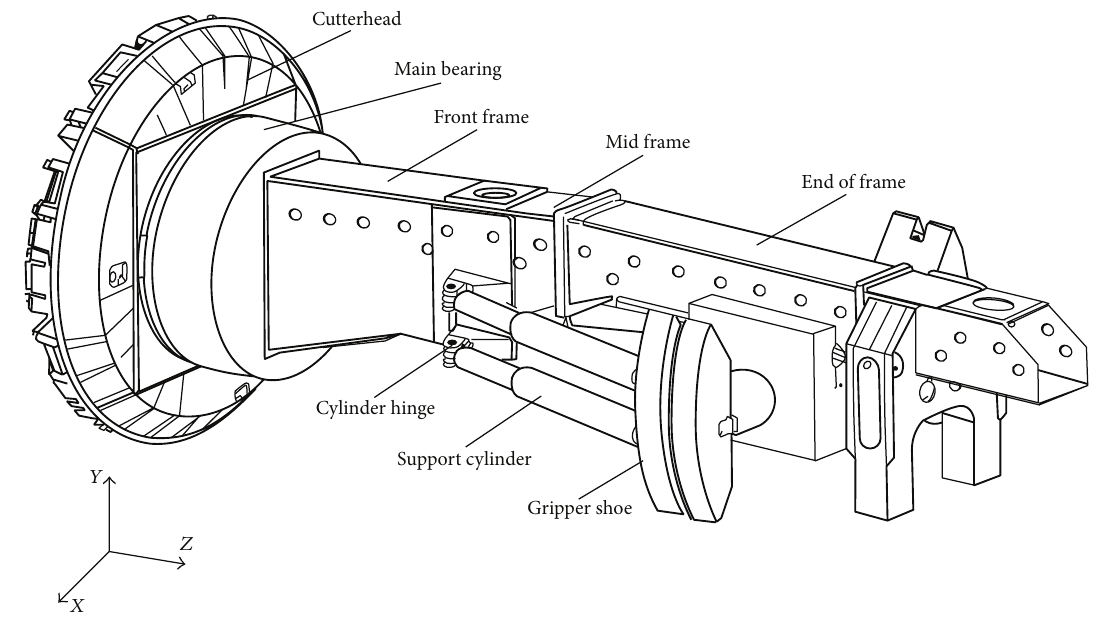
Figure 2: The component diagram of